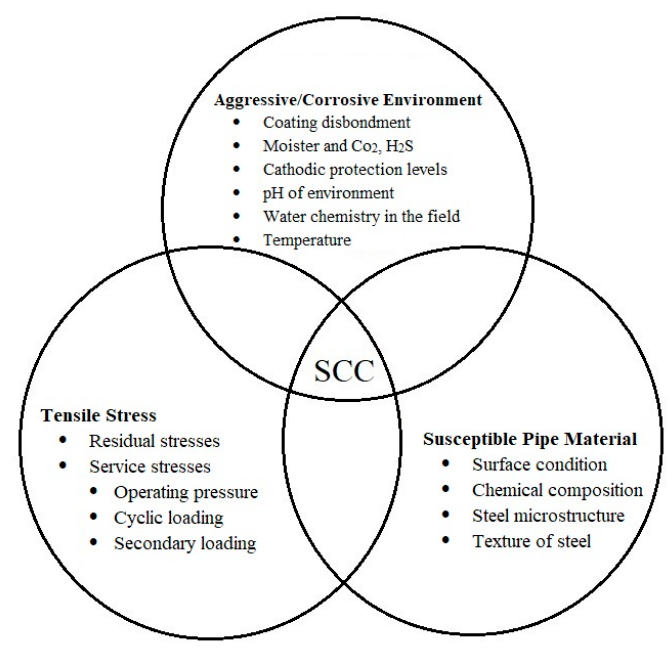
Figure 2. Effective factors for the stress corrosion cracking (SCC) crack initiation in pipeline steels.